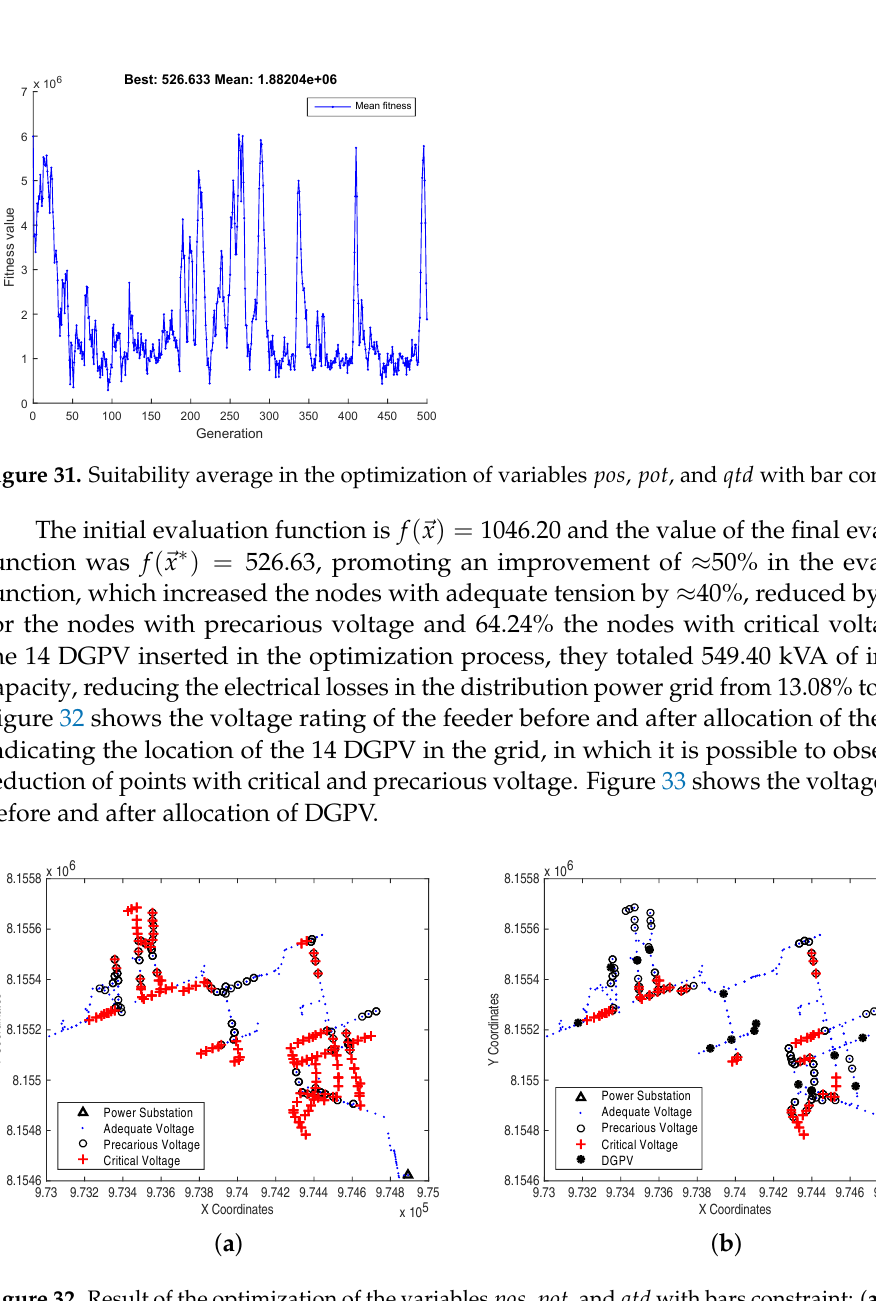
Figure 32. Result of the optimization of the variables pos , pot , and qtd with bars constraint: ( a ) voltage rating before the allocations and ( b ) voltage rating after the